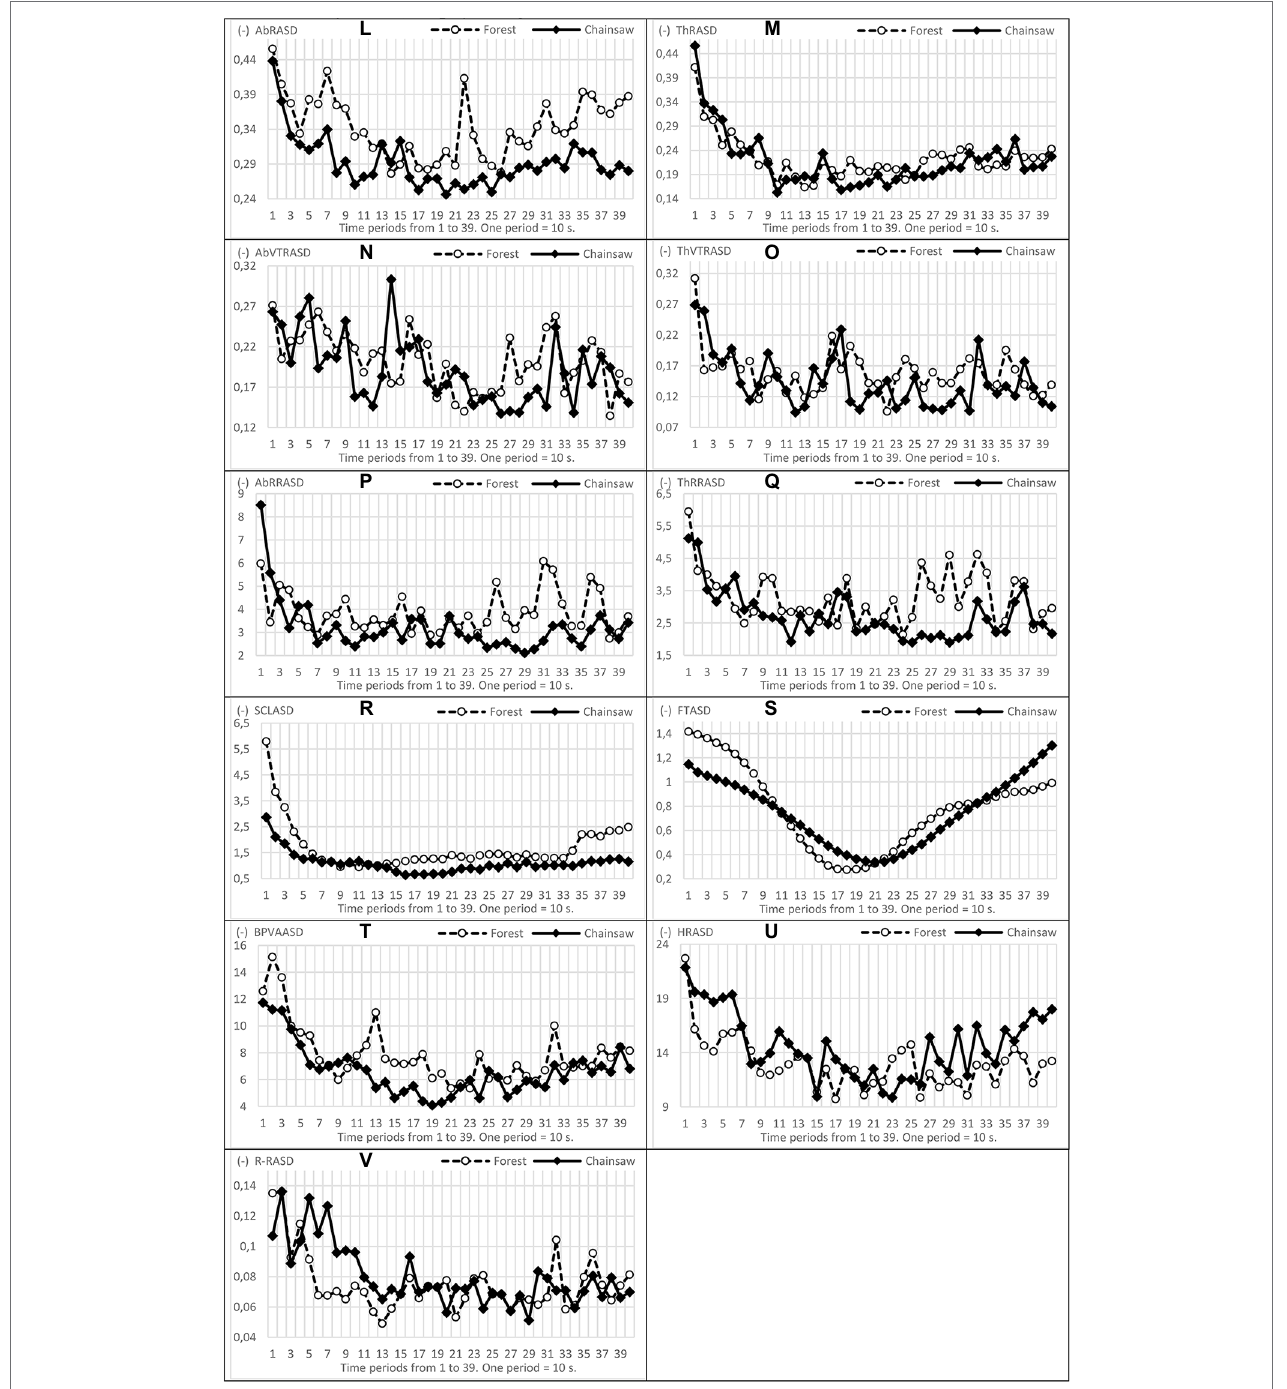
FIGURE 4 | Trends in oscillations, mild and conspicuous and ascending/descending tendencies of the variability (ASD) of physiological functions (L–V)